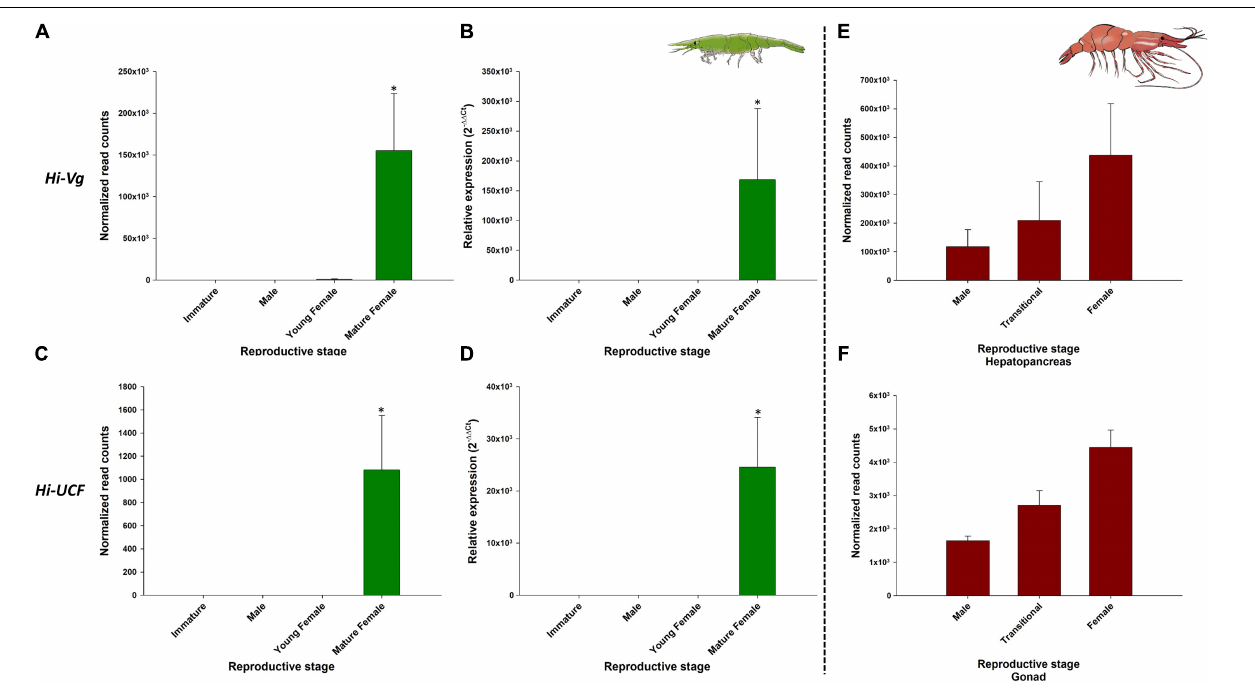
FIGURE 8 | Representative female-related genes in Hippolyte inermis and their homologs in Pandalus platyceros. Left panel - Female-related genes in different stages of H. inermis : immature ( n = 3), male ( n = 3), young female ( n = 3) and mature female ( n = 3). (A) Normalized read counts of Hi-Vg . (B) Relative expression of Hi-Vg . (C) Normalized read counts of Hi-UCF . (D) Relative expression of Hi-UCF . Right panel – Hi-Vg and Hi-UCF homologs in different stages of P. platyceros : male ( n = 2), transitional ( n = 2) and female ( n = 2). (E) Normalized read counts of Pnp-Vg . (F) Normalized read counts of a Hi-UCF homolog. Read counts of the genes in P. platyceros were obtained from Levy et al. (2020a). Error bars represent standard error of the means. * P ≤